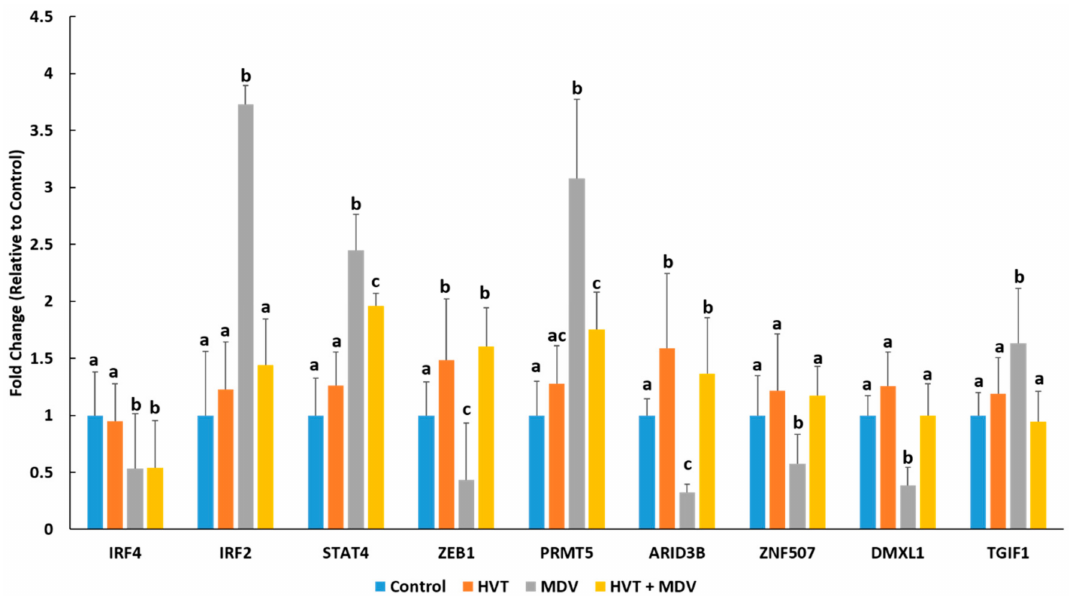
Figure 2. The splenic expression profile transcriptional regulators identified in yeast one-hybrid screenings of the chicken promoters of miR-30d and miR-10b . Expression was determined in control (mock-infected) birds ( n = 4), HVT-vaccinated birds ( n = 4), MDV-infected birds ( n = 4), and birds vaccinated with HVT and subsequently infected with MDV ( n = 4) at 42 dpi using RT-qPCR. Error bars denote standard deviations. Differing letters denote statistical significance (p < 0.05). For each gene, treatment groups with differing letters had a statistically significant difference ( p < 0.05), while groups with the same letter were not significantly different ( p >